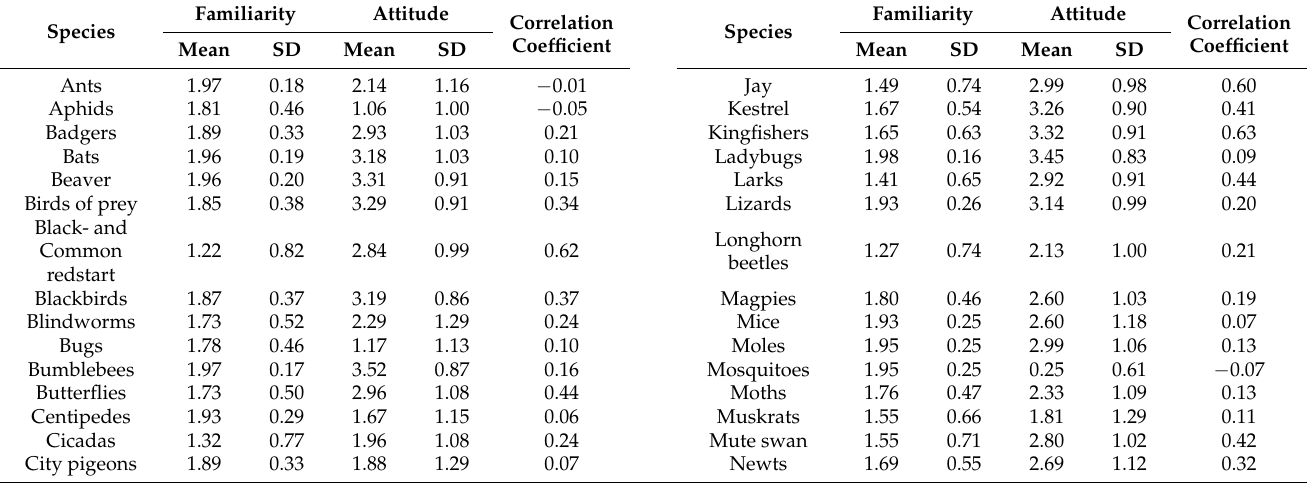
Table A2. Values for Familiarity and Attitudes and the correlation coefficient between them for each species.